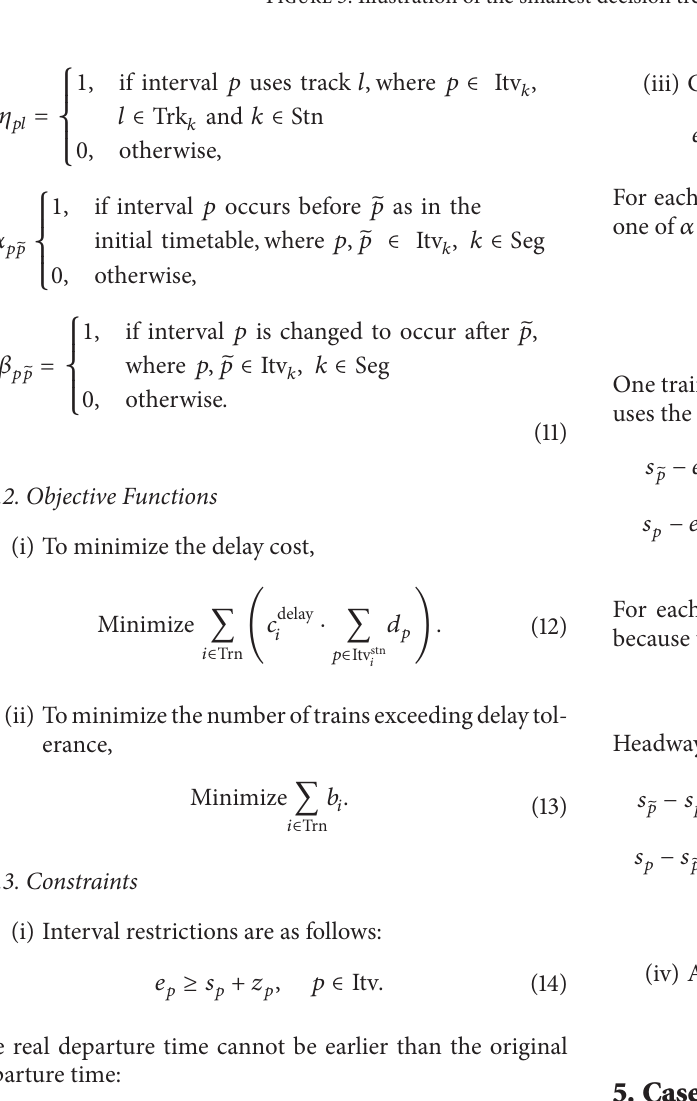
Figure 3: Illustration of the smallest decision tree obtained from Table